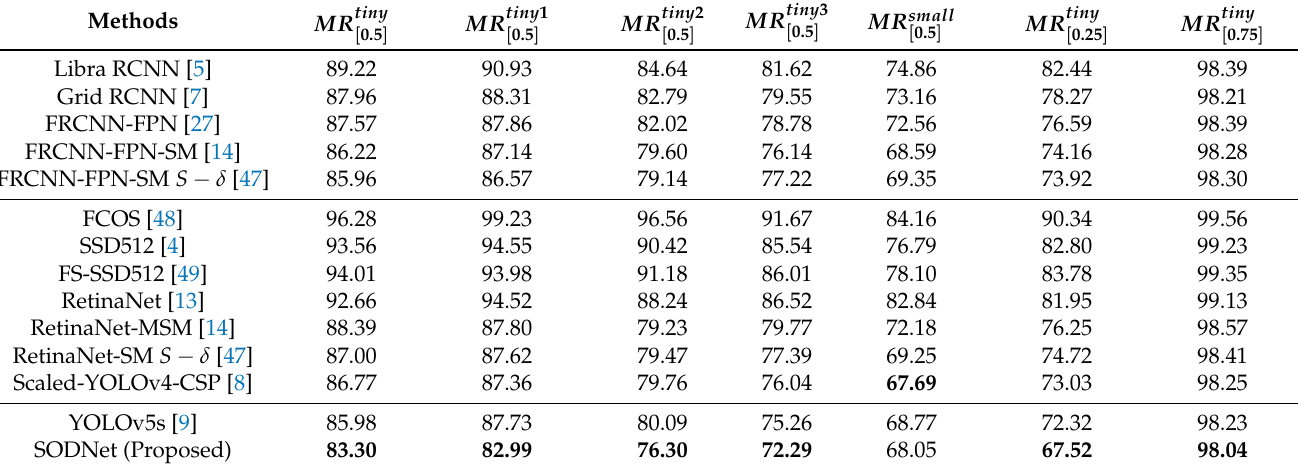
Table 2. Comparisons of MRs on TinyPerson test dataset. The best results are marked in